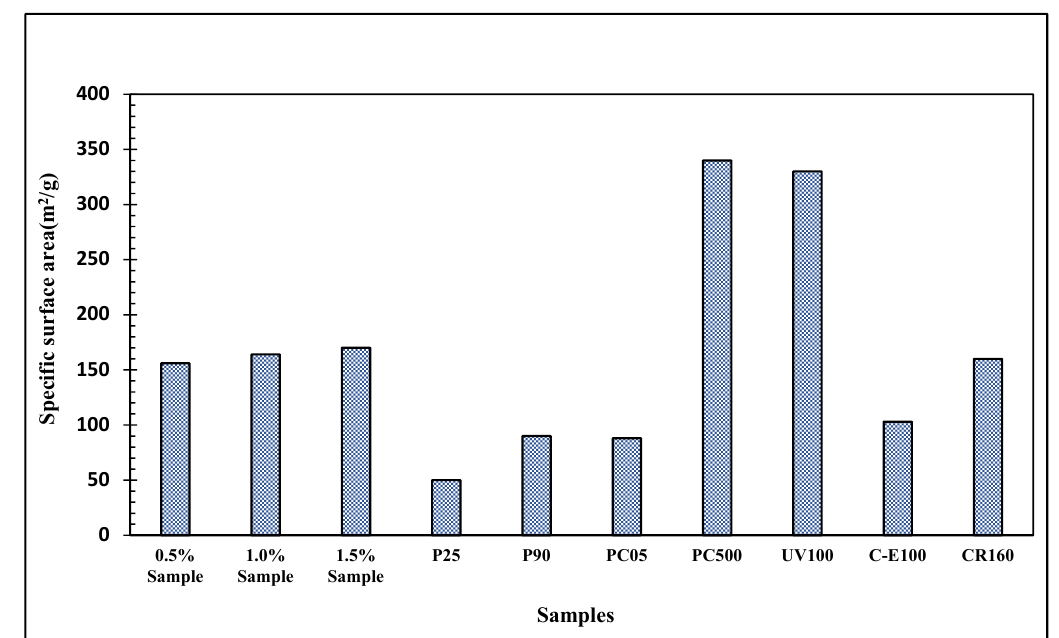
( c ) Figure 5. SEM-EDX elemental mapping of ( a ) Ti, ( b ) O, ( c ) Ir for as-synthesized 1.0 mol% Ir-doped